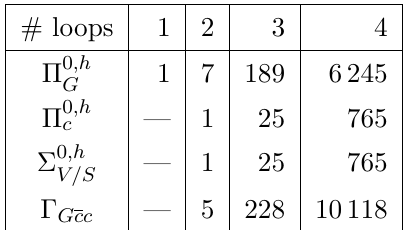
Table 1 . Number of diagrams contributing to the decoupling constants up to four